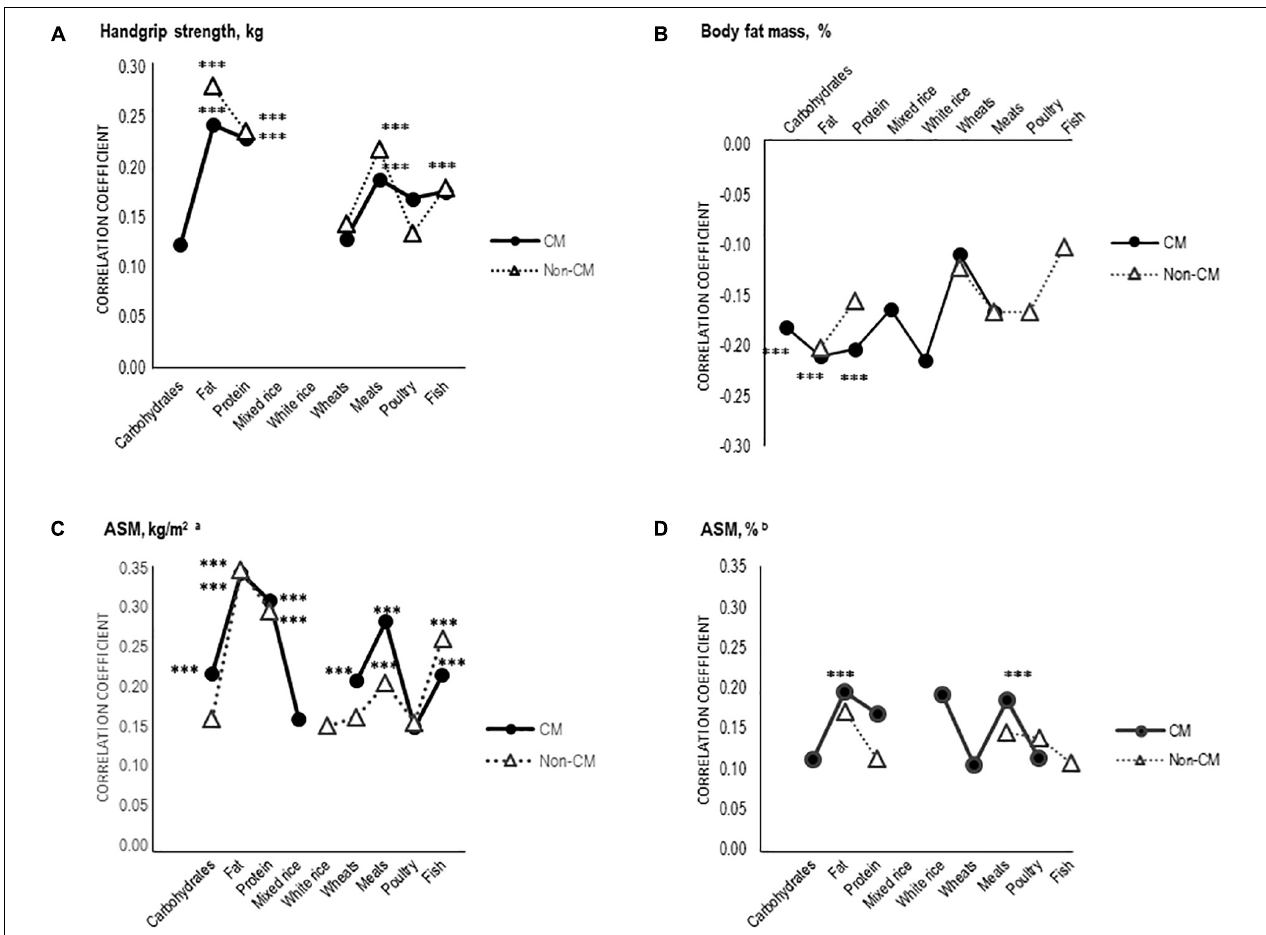
FIGURE 1 | Relationship between handgrip strength, body fat mass, appendicular skeletal muscle mass (ASM), and dietary food sources (g) of the participants by CMP. Partial Pearson correlation coefficients controlling for individual energy intake were used for the correlation analysis. Statistical significance was accepted at *** P < 0.001. C. ASM, kg/m 2 by Asian Working Group for Sarcopenia (AWGS) 2019 criteria. D. ASM, % by Janssen’s formula (ASM/weight [kg] × 100